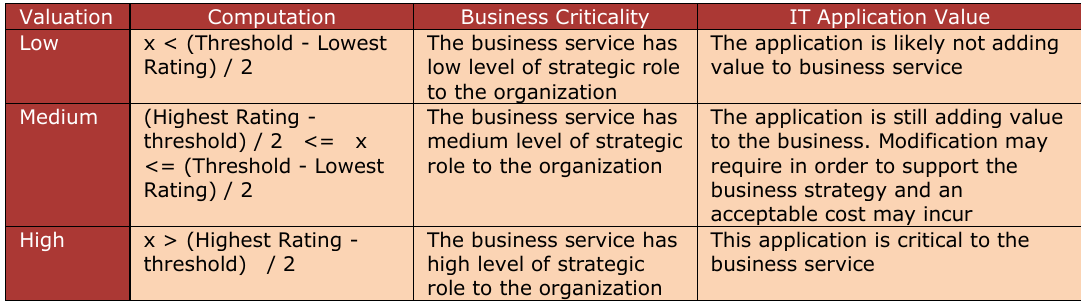
Table 6. Business services and IT application valuation result